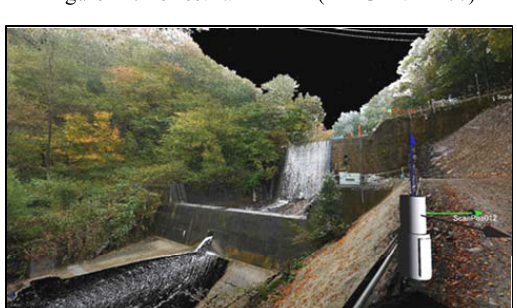
Figure 14. Terrestrial LiDAR (RIEGL VZ-400)